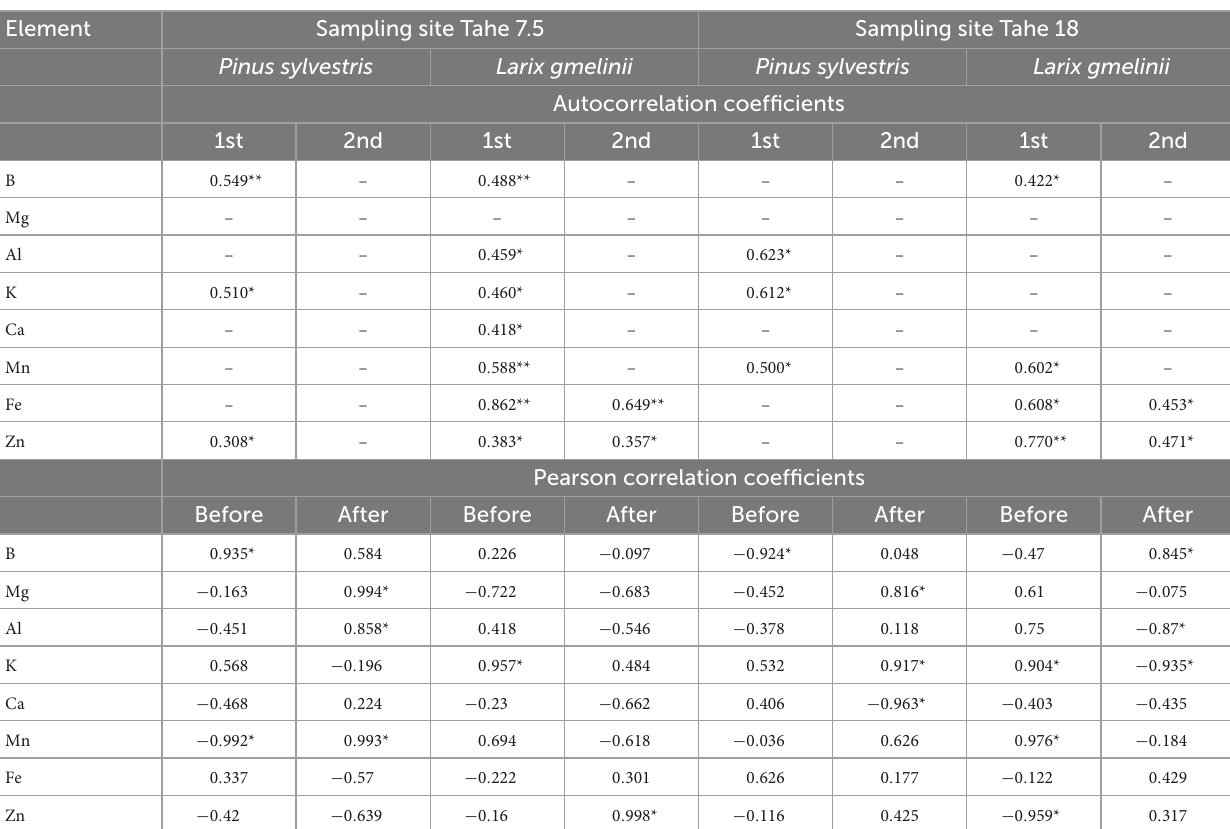
TABLE 1 Autocorrelation coefficients (with significant differences) of element concentrations and Pearson correlation coefficients (positive correlations, blue colored; negative correlations, orange colored) for tree-ring width and element concentrations in Pinus sylvestris and Larix gmelinii in the burned area of Tahe 7.5 and Tahe 18 (* P < 0.05, ** P < 0.01).